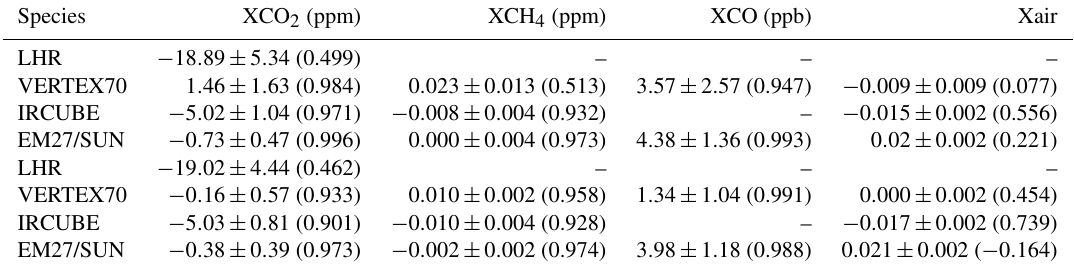
Table 6. Statistics of the intercomparison results for LHR, Vertex70, IRcube, and EM27/SUN vs. non-linearity-corrected TCCON for mea- surements performed in 2017 with SZA < 75 ◦ . The values provided are the mean bias ± the standard deviation and the correlation coefficient ( r ). The statistics in the first four rows cover the full year of measurements in 2017, while those in the last four rows are for the measurements performed between 6 July and 12 September